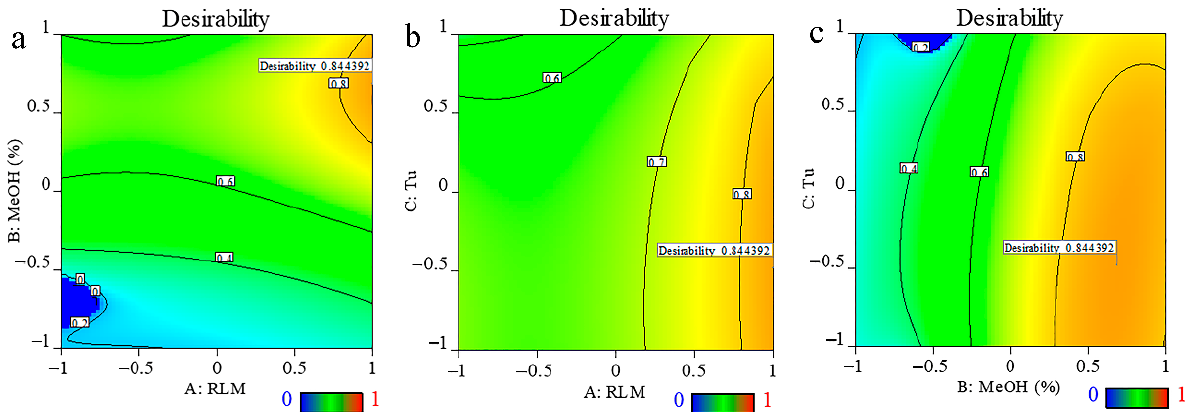
Figure 3. Desirability surface plot: ( a ) as a function of ratio of material to liquid (RLM) and percentage of methanol; ( b ) as a function of RLM and ultrasonic time; ( c ) as a function of percentage of methanol and ultra-sonic time.